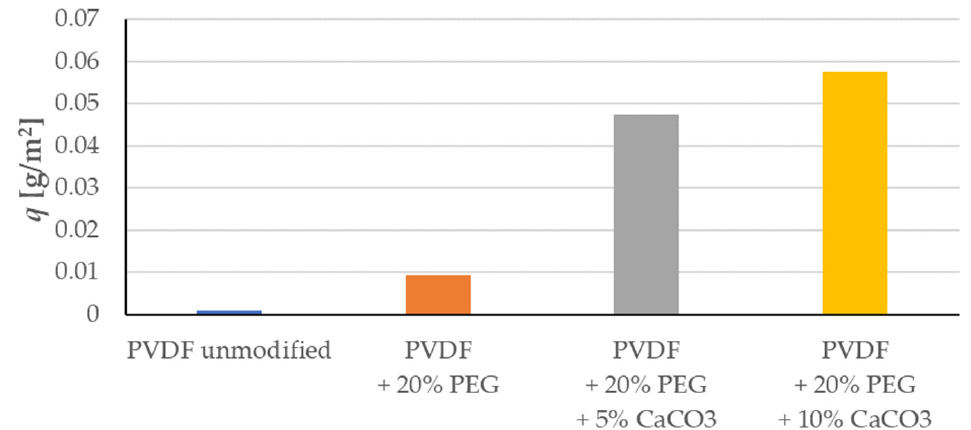
Figure 6. Mass of adsorbed sulfadiazine in the process (after 90 Figure 6 . Mass of adsorbed sulfadiazine in the process (after 90 min).